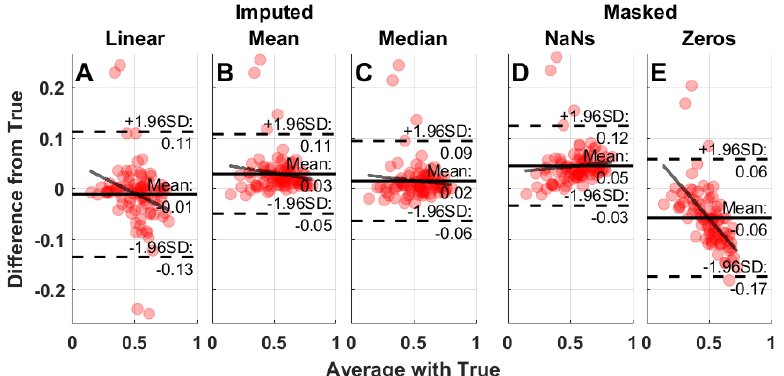
Figure 8. Sample Bland–Altman plots for IS masked with a single 5 h gap starting at 10 am and imputed. The solid black line depicts the mean, while dotted lines indicate ± 1.96 × standard deviation and the gray line represents the linear fitted slope. Performance of linear interpolation ( A ), mean imputation ( B ), median imputation ( C ), data masked with NaNs ( D ), and data masked with zeros ( E ) are presented.